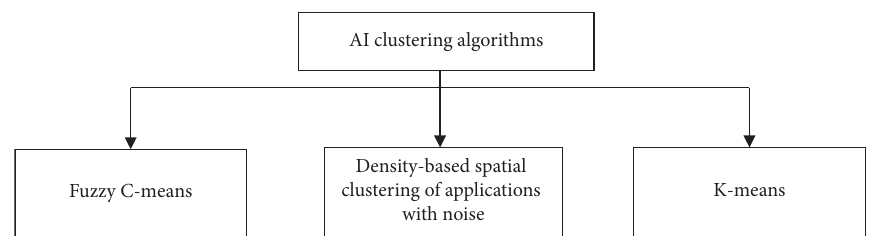
Figure 2: Commonly used AI clustering algorithms.